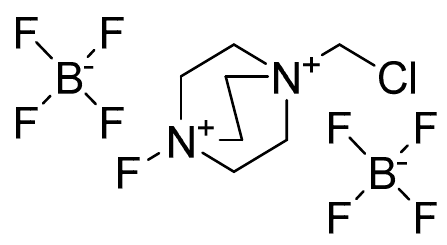
Figure 2. Structure of Selectfluor ® .